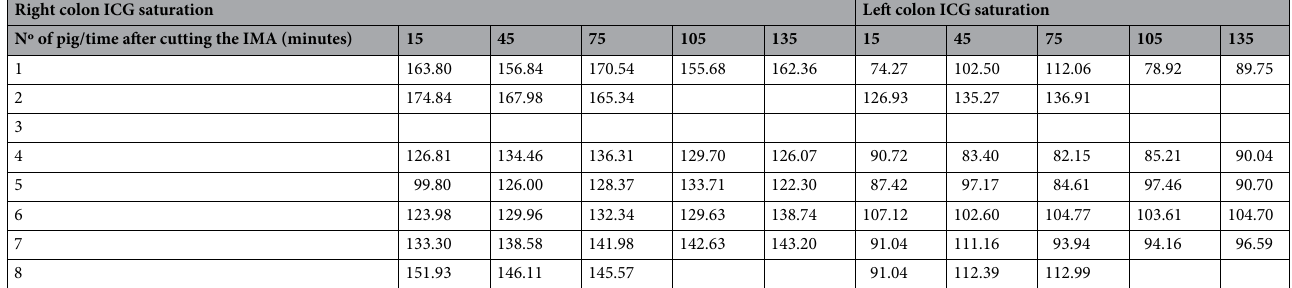
Table 2. Summary of the means for each pig and observation time in the left colon during the period of intestinal ischemia.